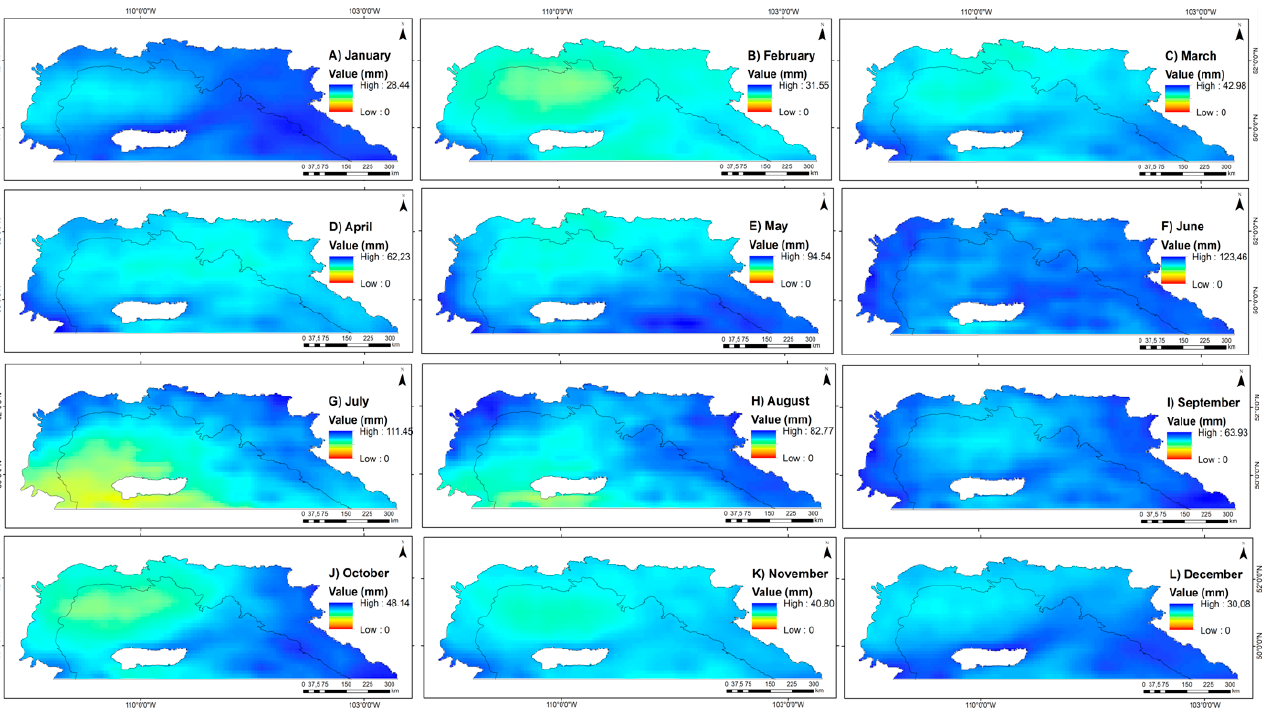
Figure 5. Average monthly precipitation—ERA5-ECMWF (mm monthly − 1 ) in the period